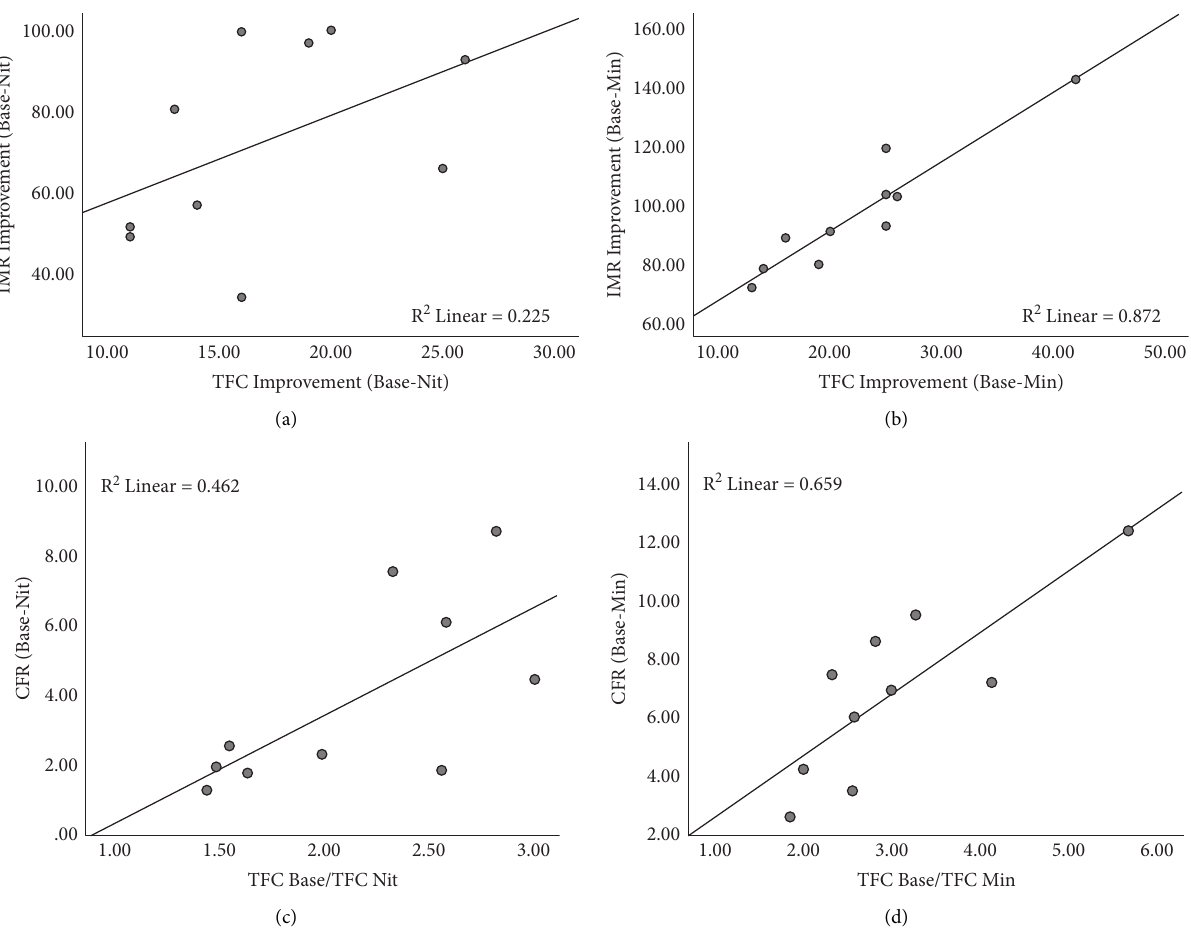
Figure 4: Correlation between the improvement of TFC and IMR. (a) No significant correlation in the actual value improvement between TFC Base-Nit and IMR Base-Nit ( r � 0.549, P � 0 . 10). (b) A significant correlation between the actual value improvement between TFC Base-Min and IMR Base-Min ( r � 0.926, P < 0 . 001). (c, d) A significant correlation between the ratio of TFC Base/Nit and CFR Base/Nit ( r � 0.685, P � 0 . 029) as well as between TFC Base/Min and CFR Base/Min ( r � 0.758, P � 0 . 011). ∗ Base: baseline; Nit: measured after nitroglycerin injection; ATP: measured after ATP injection; Min: measured after sequenced nitroglycerin and ATP